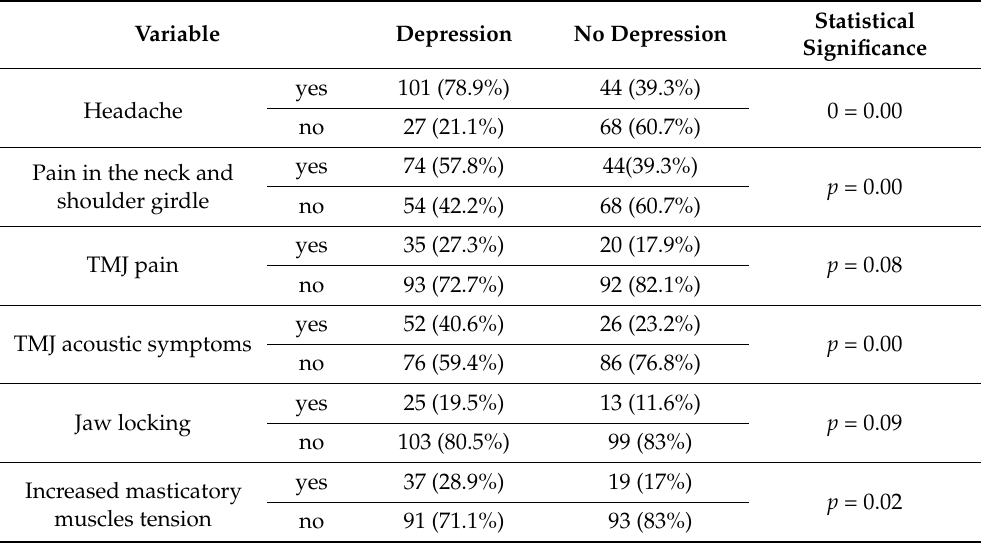
Table 4. Analysis of reported TMD symptoms and the occurrence of